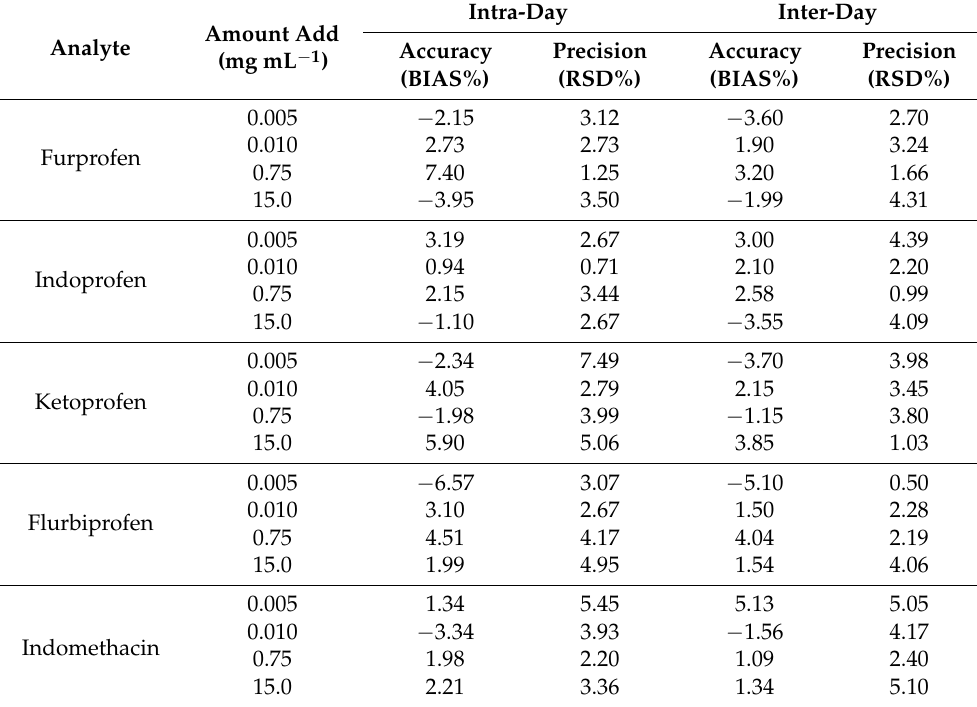
Table 1. Intra- and inter-day precisions of the proposed MSPE method in human plasma.